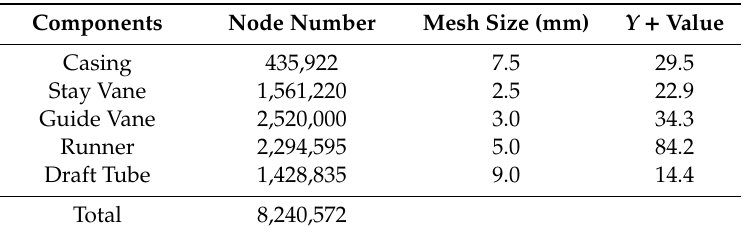
Figure 13. Mesh dependency test results for CFD analysis. Table 7. Numerical grids information.